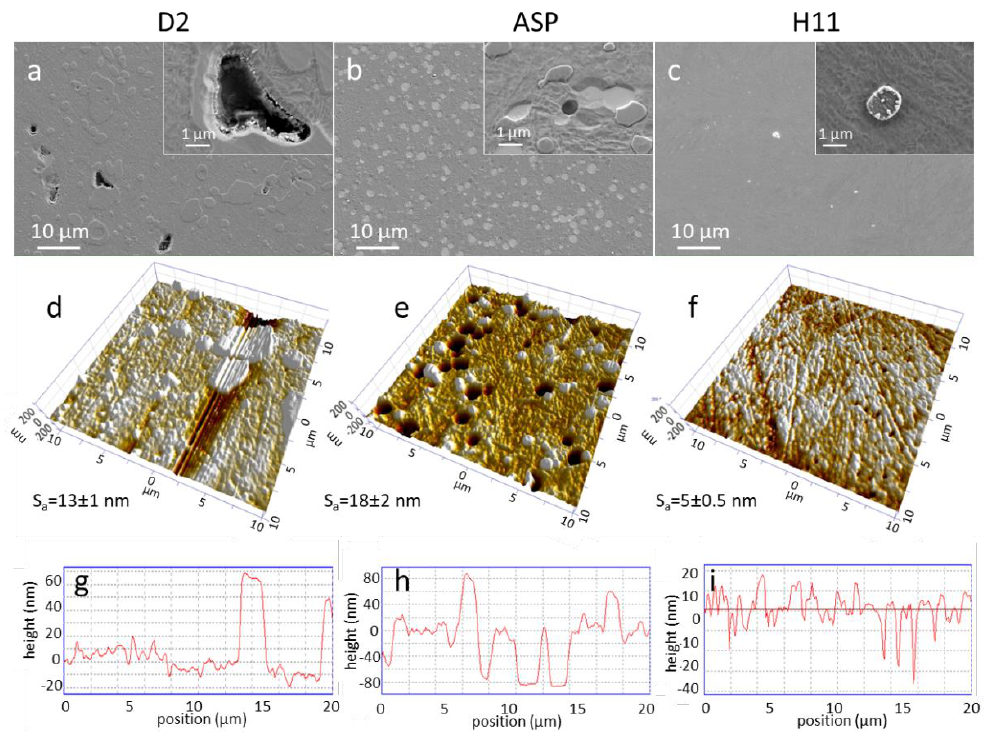
Figure 6. SEM images ( a – c ), AFM images ( d – f ), line profiles ( g – i ) and surface roughness (S a ) of D2, ASP30 and H11 tool steel substrates after DC ion etching in BAI deposition system. The scan area and z-scale are 20 µm × 20 µm and 200 nm, respectively.